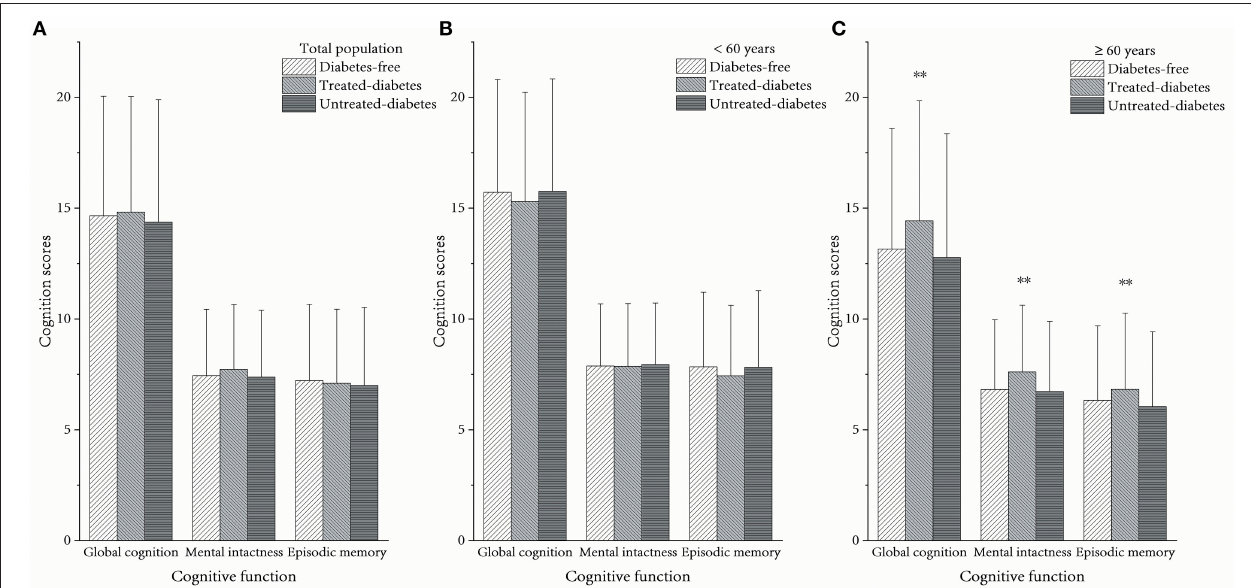
FIGURE 1 | Average cognition scores between different diabetes statuses. (A) In the total population, (B) in the population aged < 60 years, and (C) in the population aged ≥ 60 years. **The scores among the three groups were significantly different as p < 0.05.